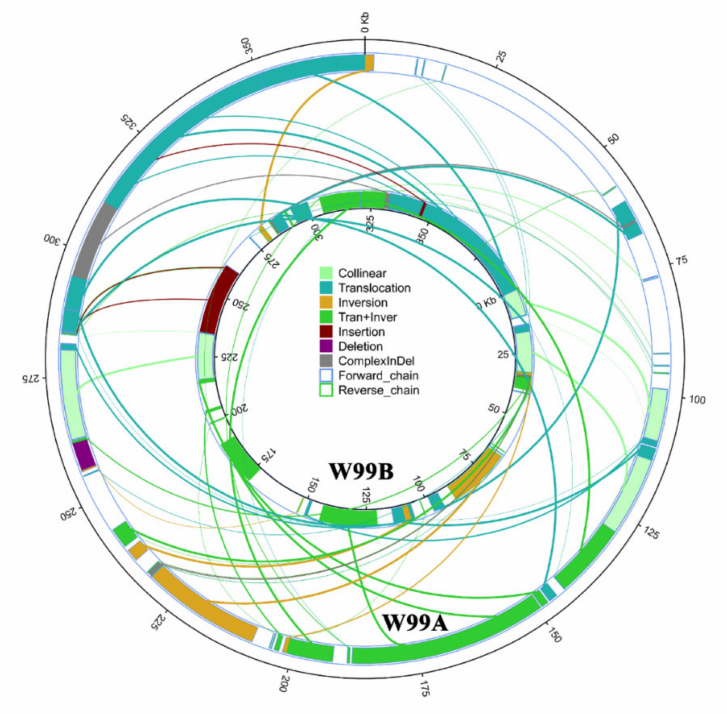
Figure 4. The structural variation map of W99A and W99B mitochondrial